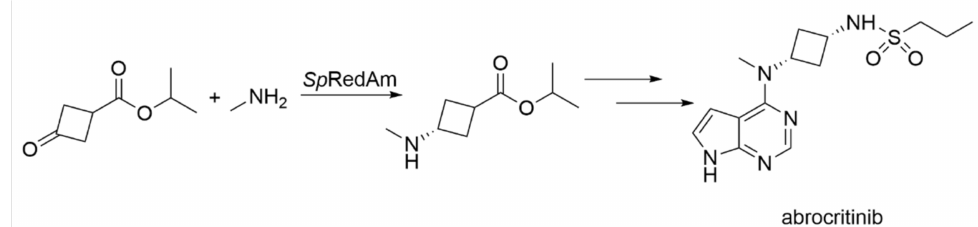
Figure 3. Biocatalytic synthesis of a key intermediate of abrocritinib catalyzed by the engineered reductive aminase Sp RedAm from Streptomyces purpureus